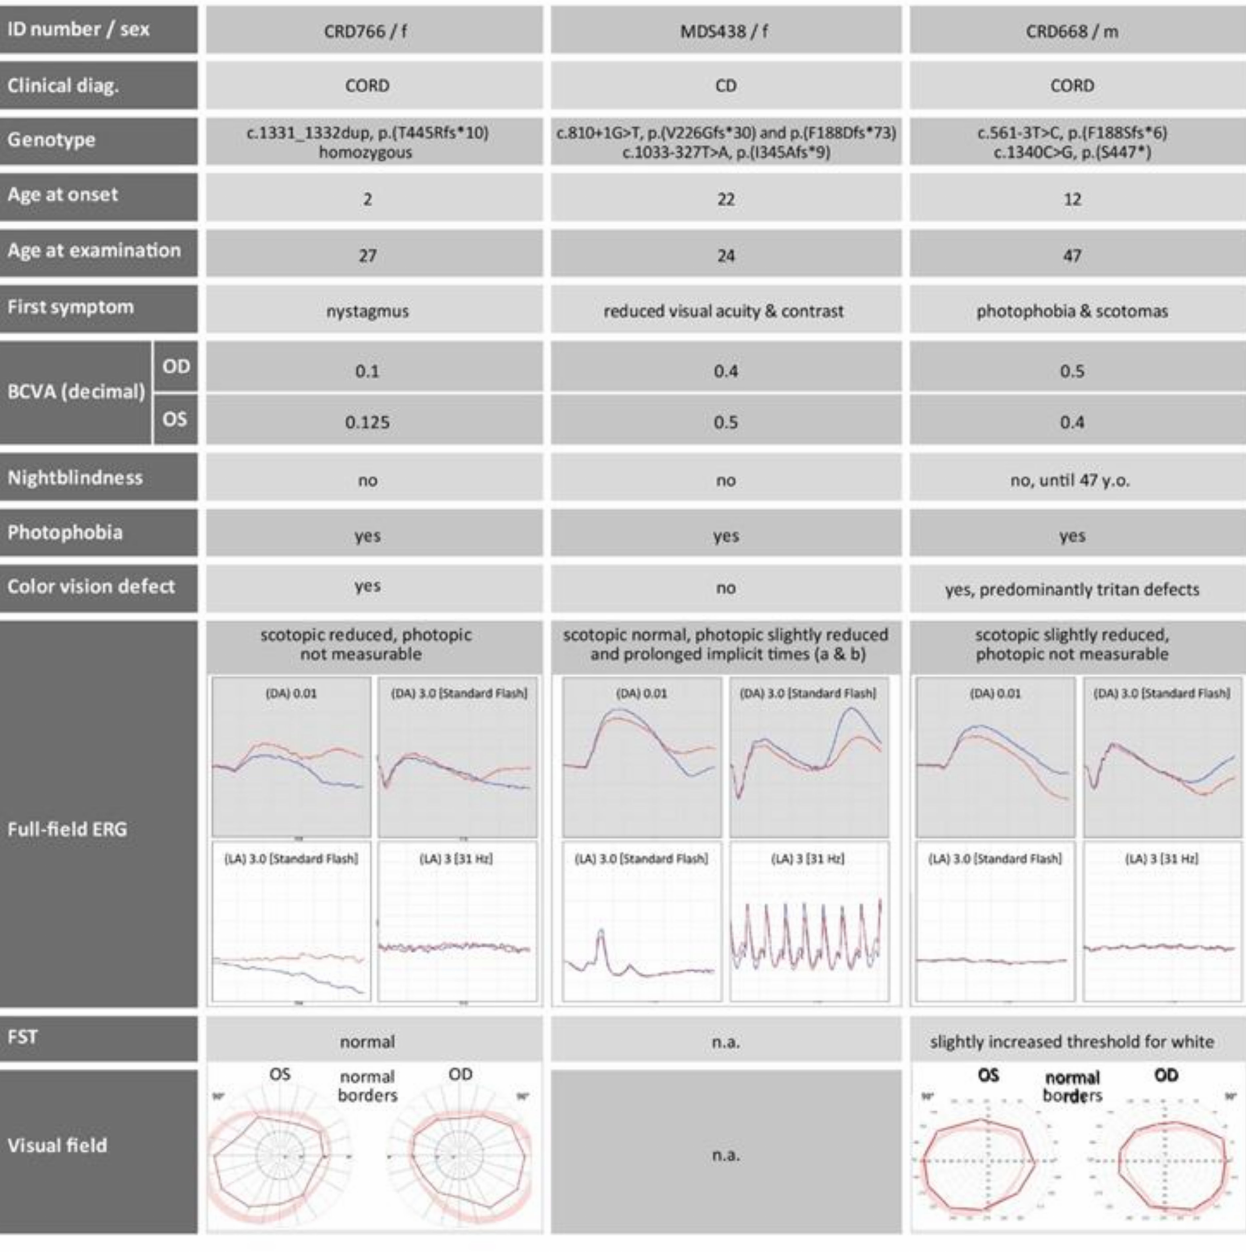
Figure 1. Medical history and retinal functional diagnostics of the three patients described in this study. F, female; m, male; CORD, cone-rod dystrophy; CD, cone dystrophy; OD, right eye; OS, left eye; n.a., not available; BCVA, best corrected visual acuity; DA, dark adapted; LA, light adapted; FST, full-field stimulus threshold. Age is given in years. Mutation nomenclature refers to POC1B with GenBank accession number